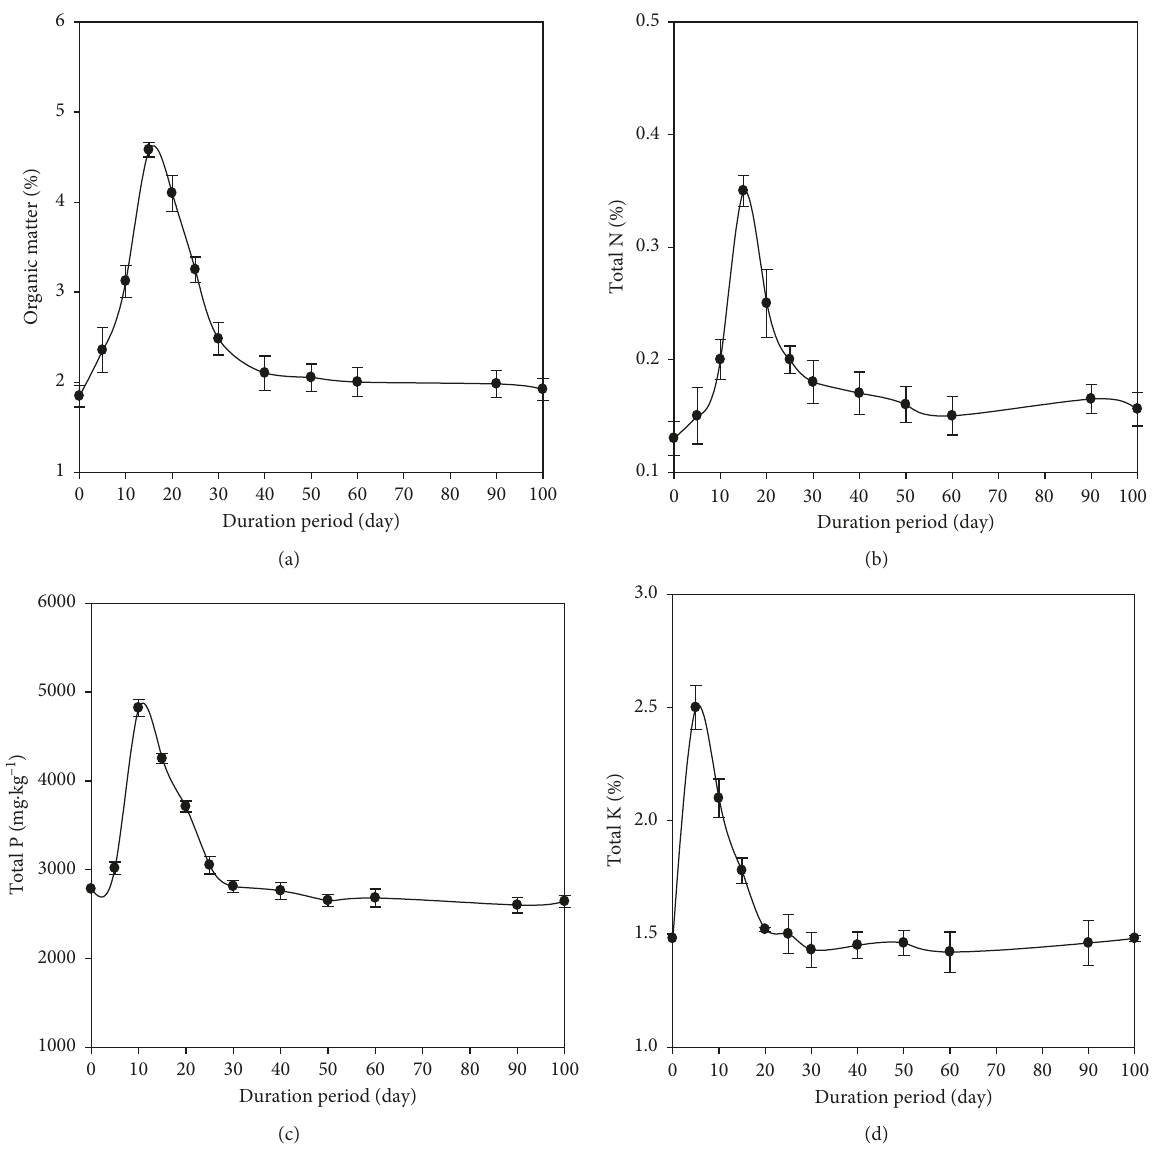
Figure 5: The changes in contents of (a) organic matter, (b) total N, (c) total P, and (d) total K as a function of the duration period after HCl leaching and fertilized by organic